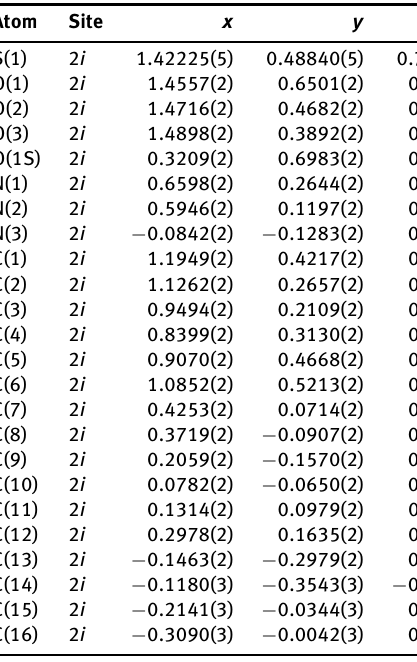
Table 3: Atomic displacement parameters (Å 2